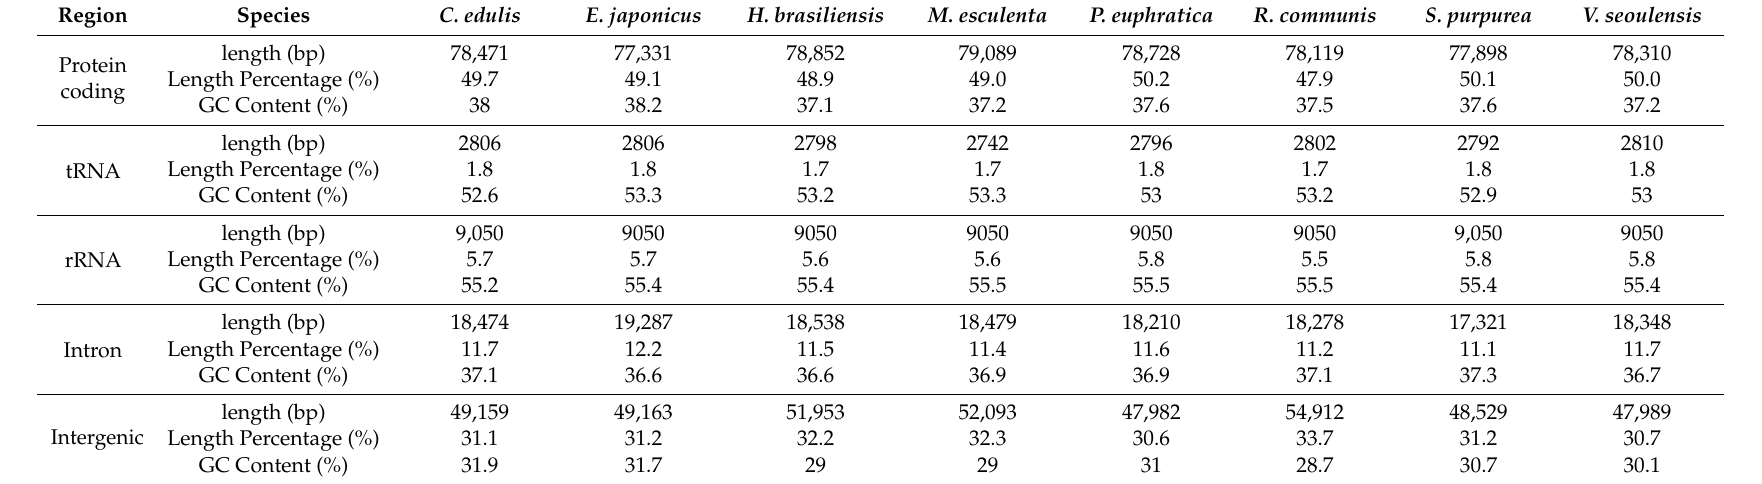
Table 2. Comparison of coding and non-coding region size among eight